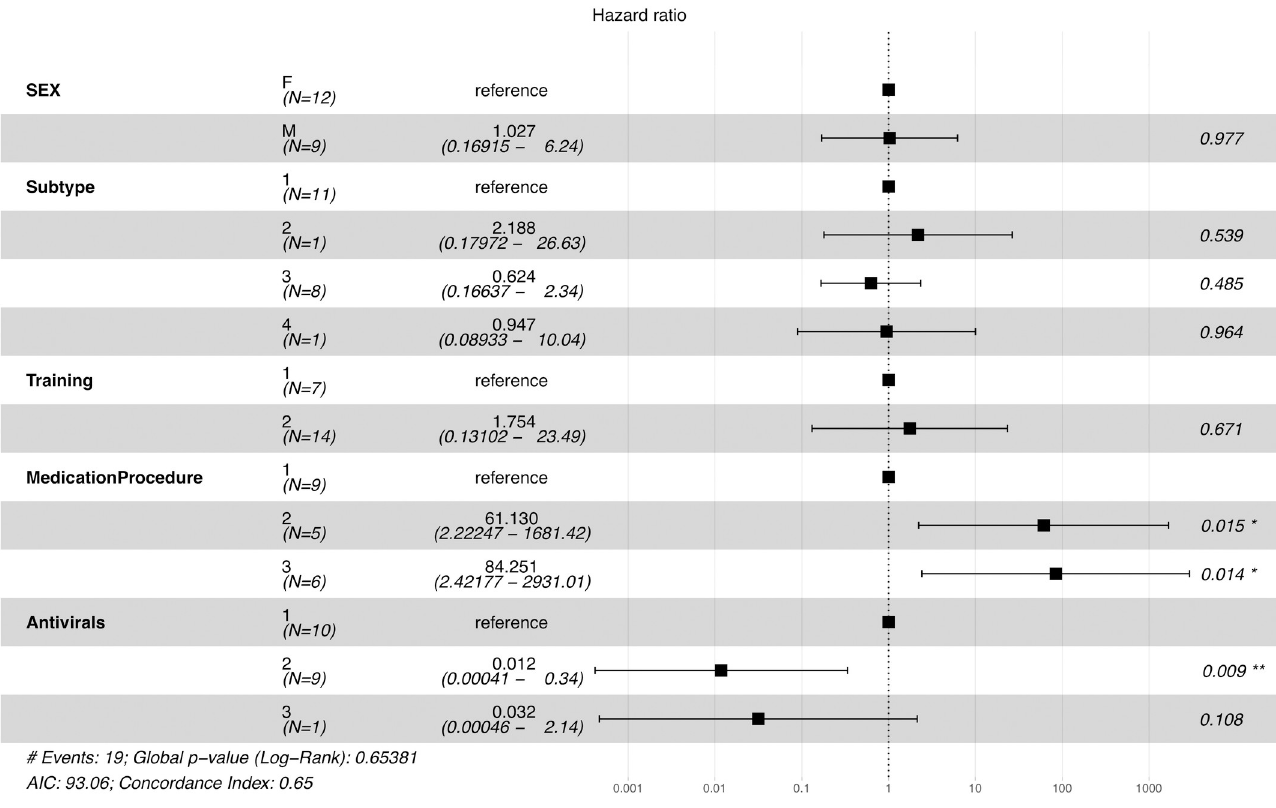
Fig 4. Hazard ratio estimated along with confidence intervals and p-values for each variable.